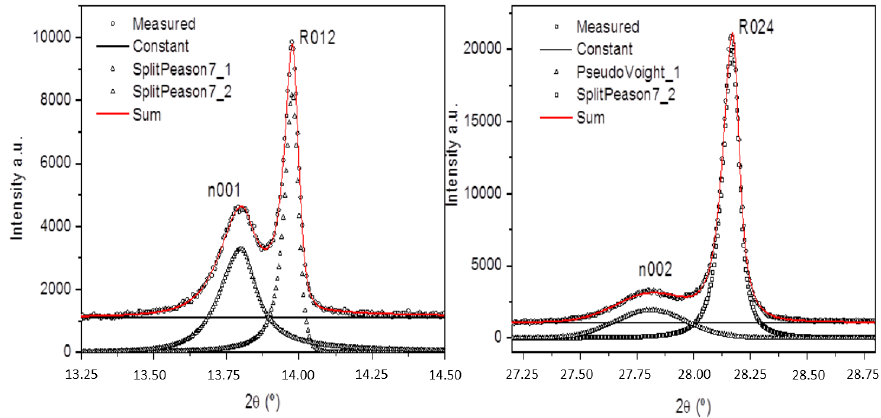
Figure 22. Magnification of two peaks showing the 2 θ angular dependence of the intensity of the humps. Peak fitting was carried out using the software described in [36].